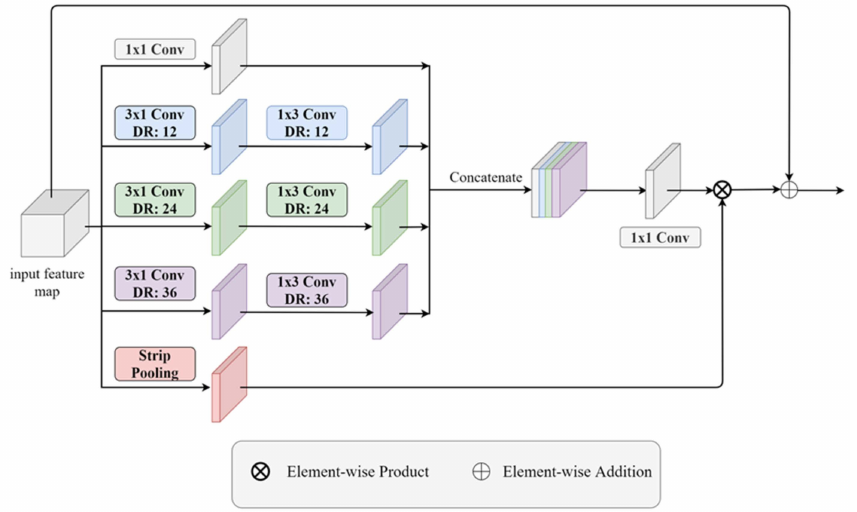
Figure 4. Factorized atrous spatial pyramid pooling